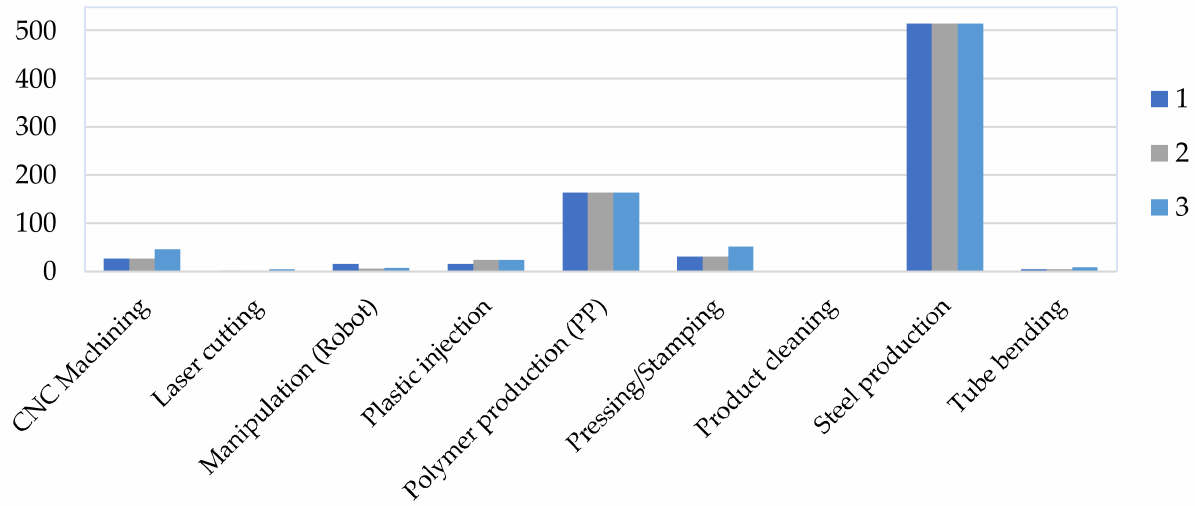
Figure 10. Total CO 2e generated depending on the analyzed scenario and on the concerned machine due to the transport and storage of the electricity used (t of CO 2e ).